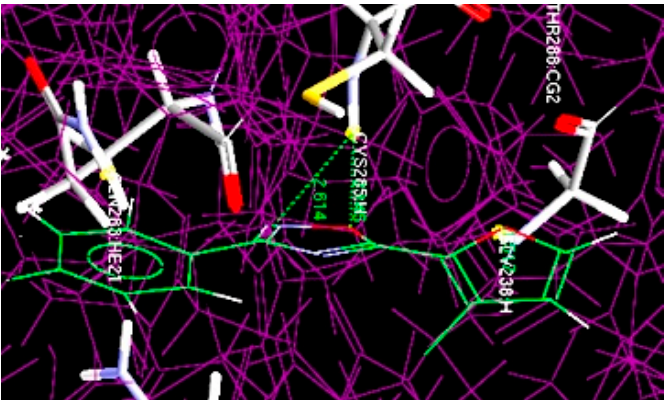
Figure 3. Overlay of docked highest potent oxadiazole compound ( 4m ) at the active site of 1RE1.